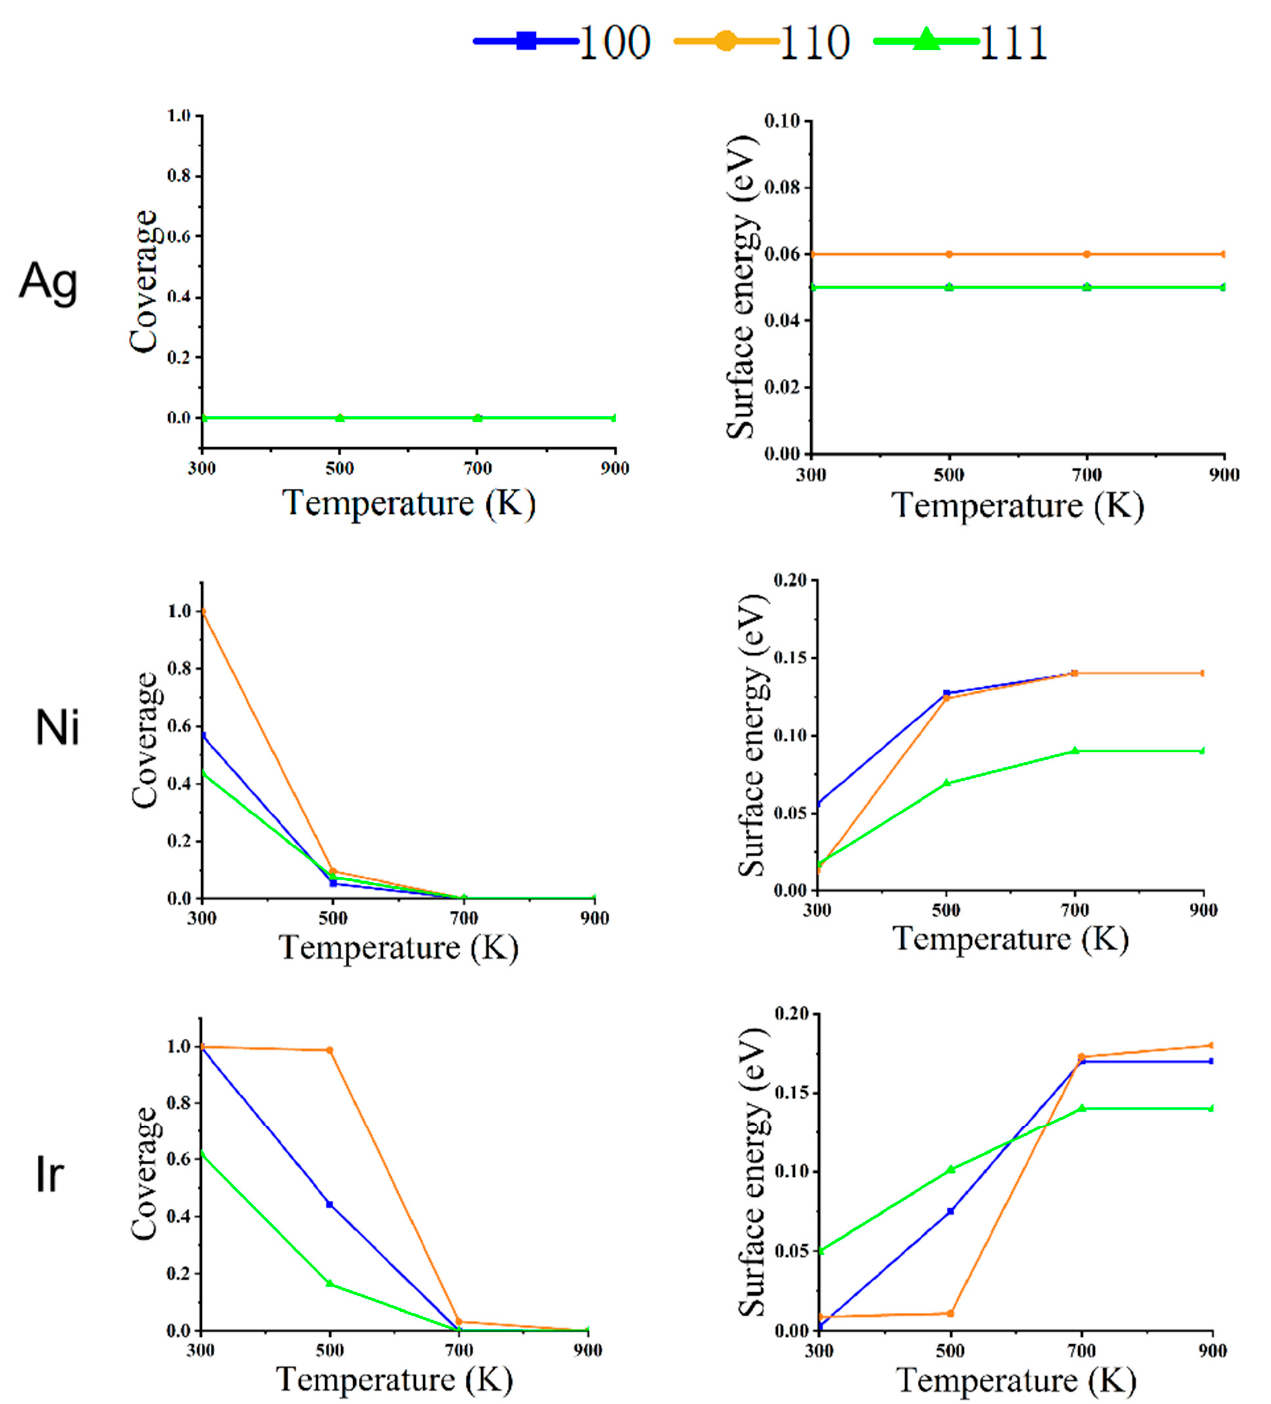
Figure 4. The relationship between the coverage of CO ( left ) and surface energy ( right ) on the different faces of metal NPs (Ag, Ni, and Ir) at changing temperatures and a pressure of 1 Pa. Ni NPs show significant structural changes at a pressure of 1 Pa. At 300 K, CO coverage on (110) is 100%, (100) is 57%, and on (111) is 44%. Since the repulsion energy of CO on the (110) surface is minimal compared to the other two surfaces, the equilibrium structures of Ni NPs are all rhombic dodecahedra composed of the (110) surface. When the temperature increases from 300 to 500 K, the CO adsorption on the three low-index surfaces decreases rapidly to near zero. The (111) surface has the smallest surface energy relative to the